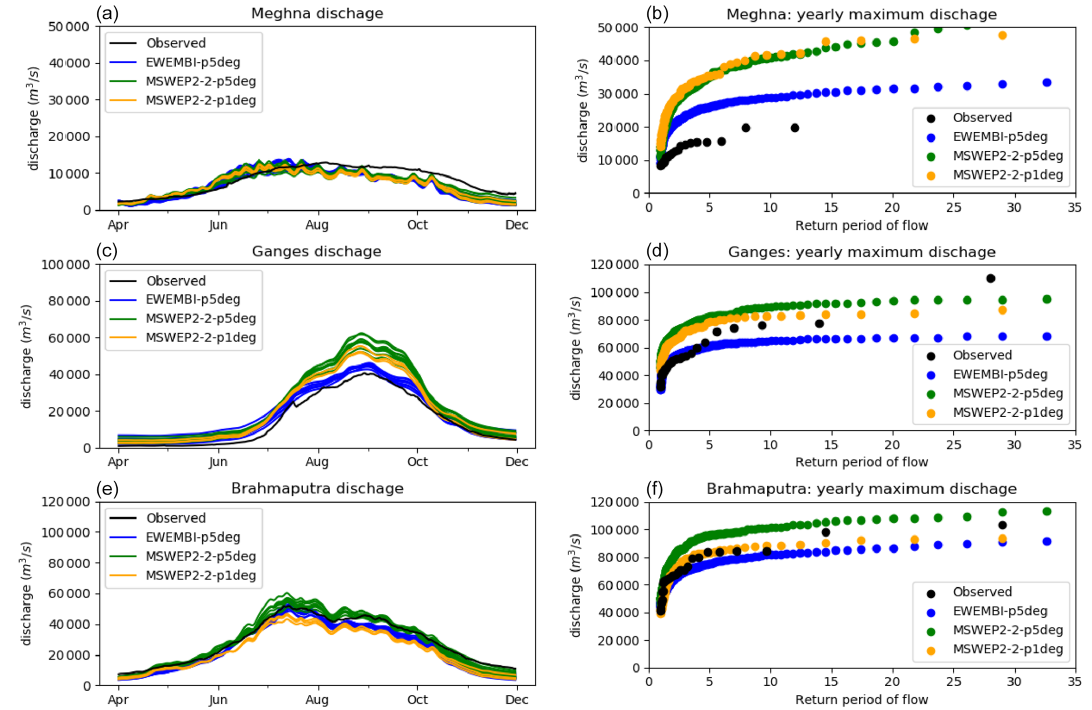
Figure 8. Comparison between observed and modeled streamflow for three stations on the Meghna (a, b) , Ganges (c, d) and Brahmaputra (e, f) . Panels (a, c, e) show seasonal cycle and panel (b, d, f) show return periods for yearly maximum discharge. Different lines in the same color show different FUSE structures with different parameter